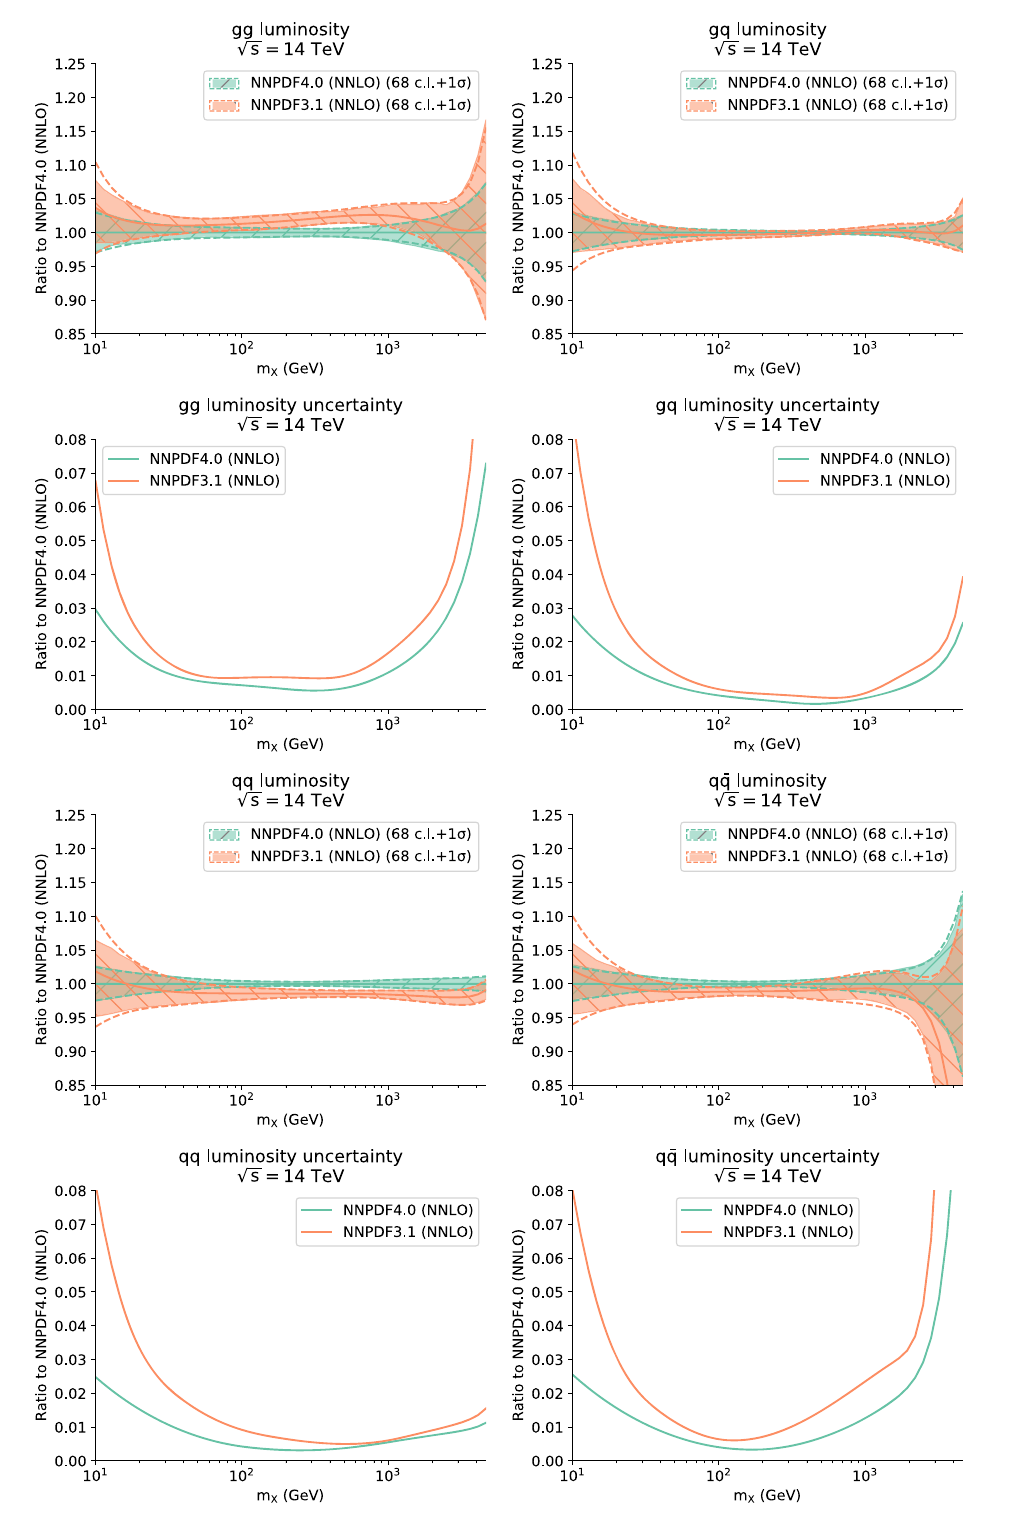
Fig. 58 Comparison,asafunctionoftheinvariantmass m X ,ofthepar- √ s = 14 TeV computed using NNLO NNPDF4.0 ton luminosities at and NNPDF3.1 PDFs, where the luminosities have been integrated over